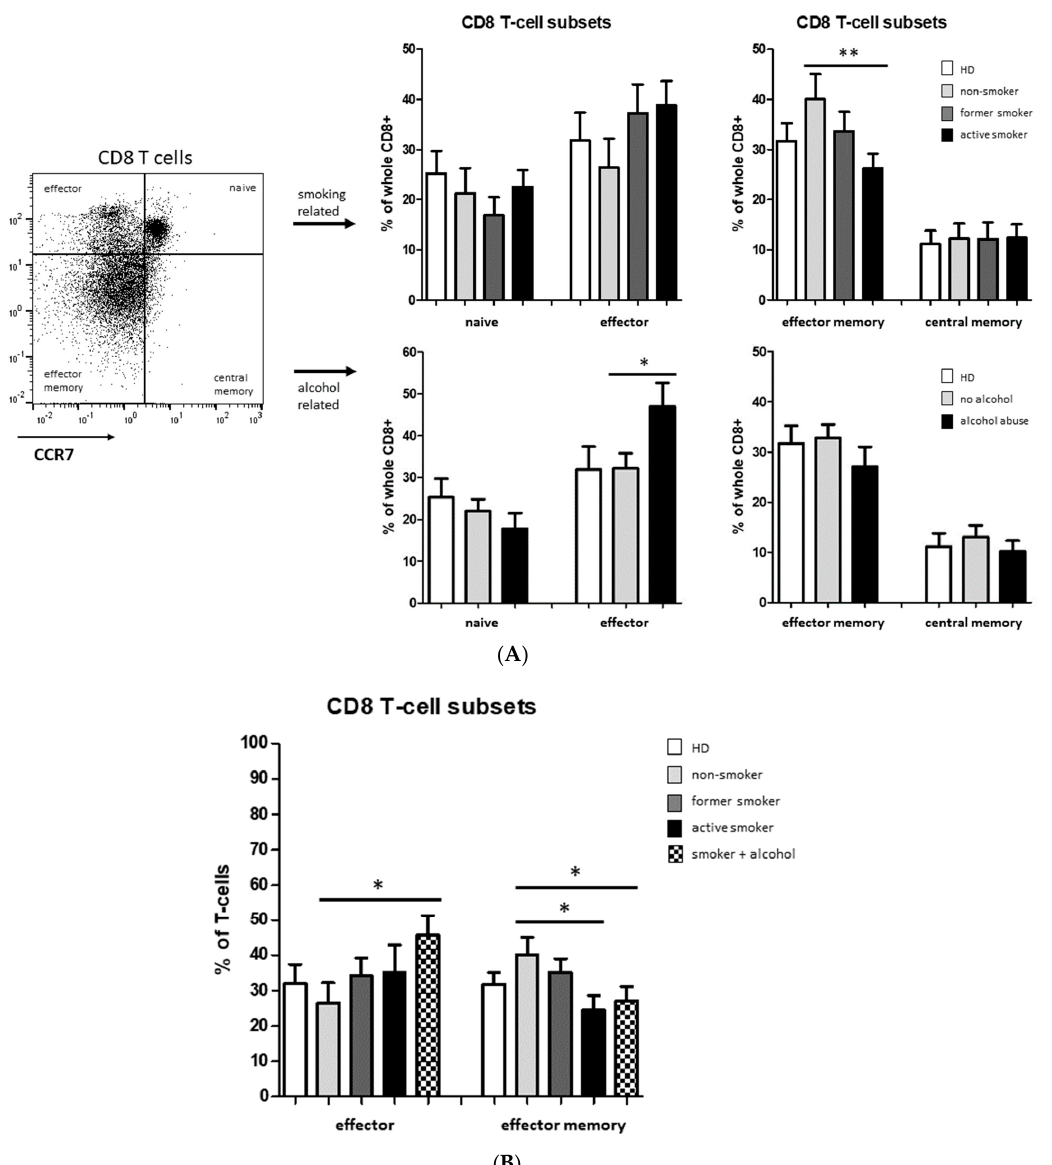
Figure 6. Flow cytometric analysis of CD8 + T cell subsets in PBMC from healthy donors as well as smoking- and alcohol-related HNSCC patients. ( A ) Example gating scheme and percentages of naïve, effector, effector memory, and central memory T cells within CD8 + T cells. ( B ) Flow cytometric analysis revealed significantly increased percentages of CD8 + effector T cells in smoking + alcohol abuse-related patients and significantly decreased percentages of CD8 + effector memory T cells in in active-smoking as well as in smoking + alcohol abuse-related patients compared to non-smoking/non-drinking patients. * p < 0.05; ** p < 0.01.